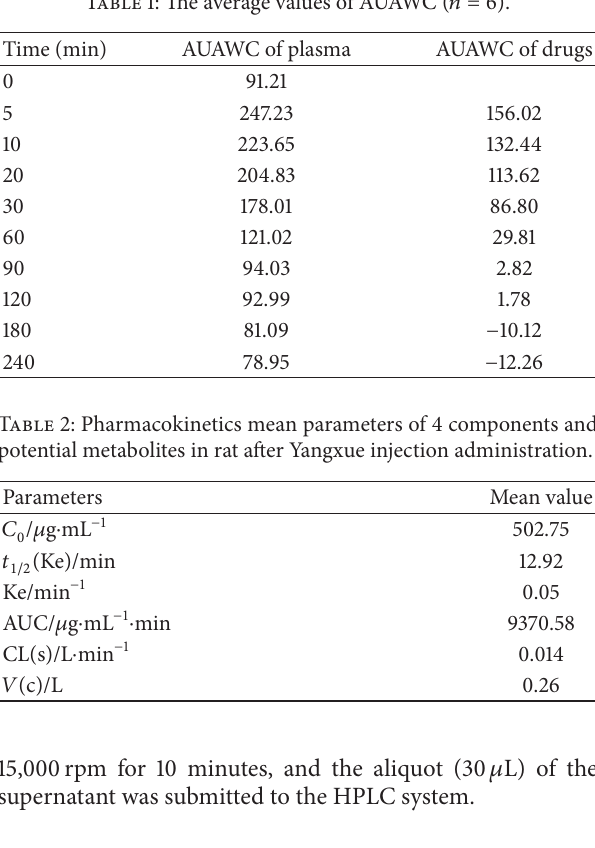
Table 1: The average values of AUAWC (𝑛 = 6) .